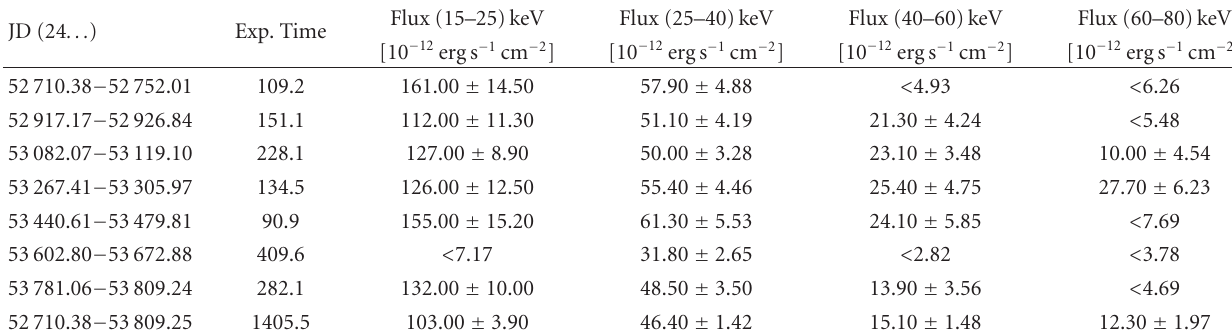
Table 2: IBIS observations of V1223 Sgr.